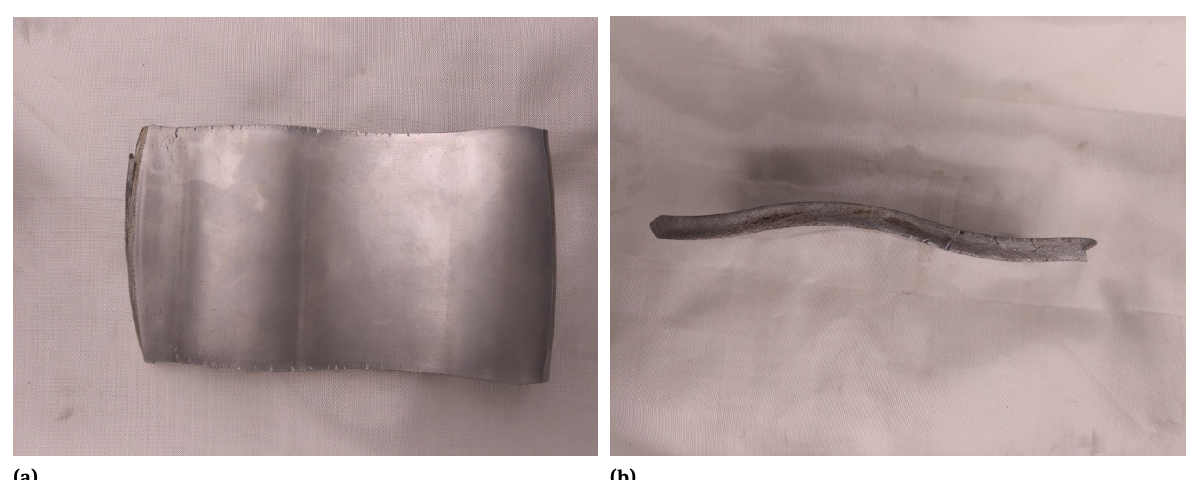
Figure 7: View of the fourth billet after rolling: a - from above; b - on the